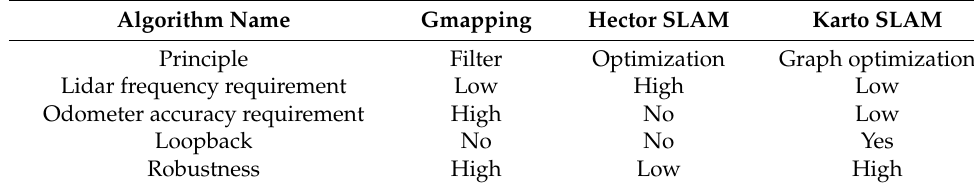
Table 2. SLAM Algorithm